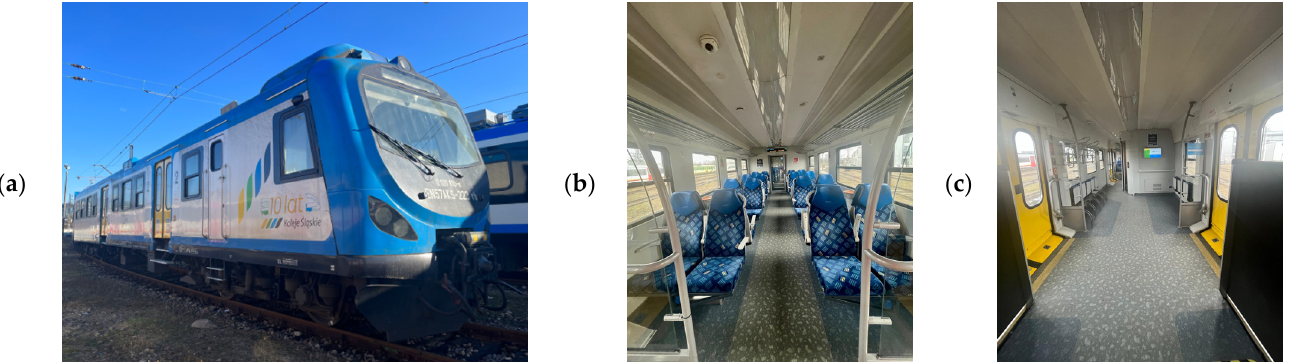
Figure 3. Electric multiple unit of the EN57AK Ś -223 series: ( a ) front end with the whole vehicle visible; ( b ) passenger compartment; ( c ) passenger and bicycle compartment.